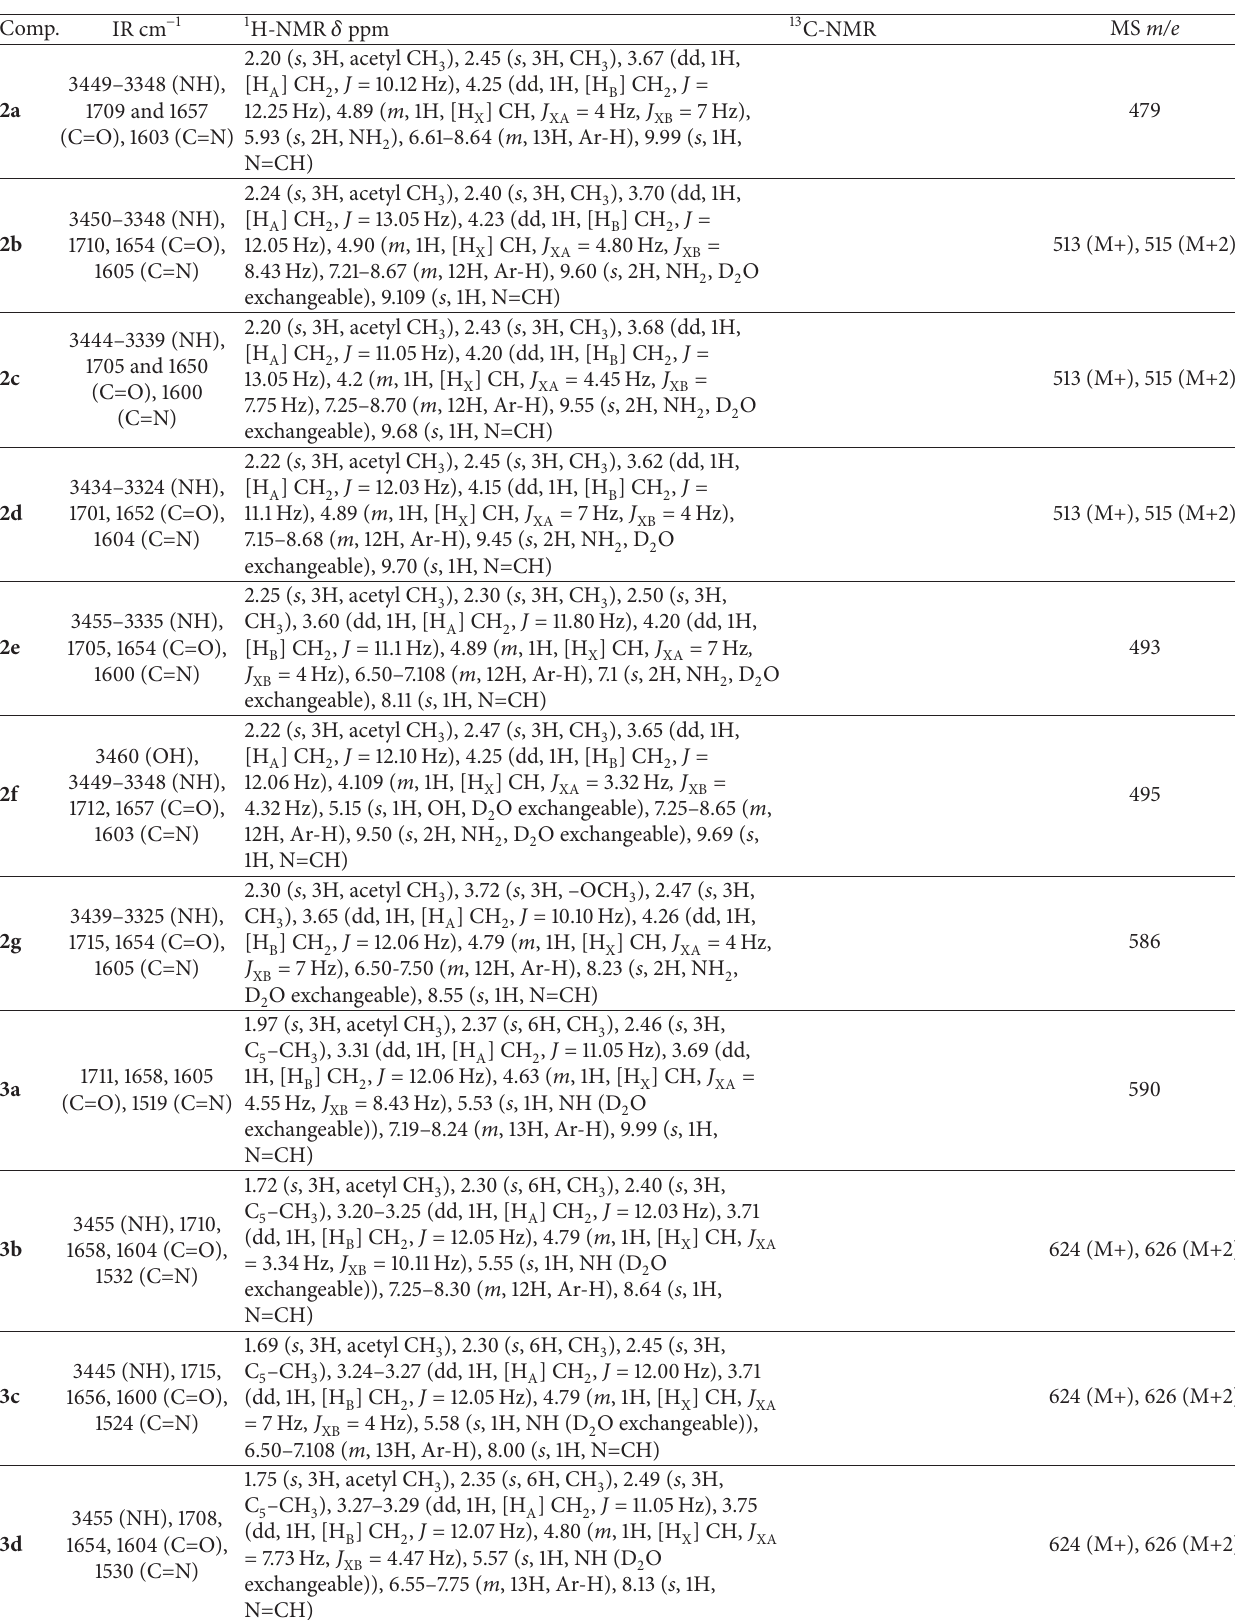
Table 2: Spectral data of synthesized